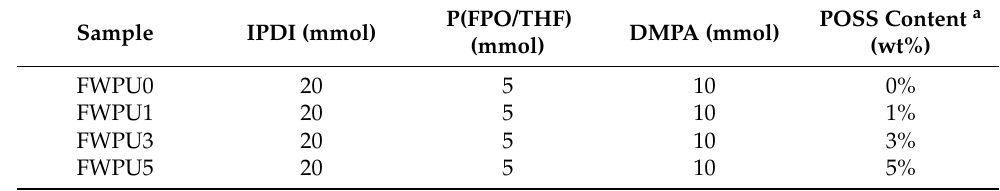
Table 1. The formulations of POSS for the preparation of POSS-based FWPU dispersions. Sample IPDI